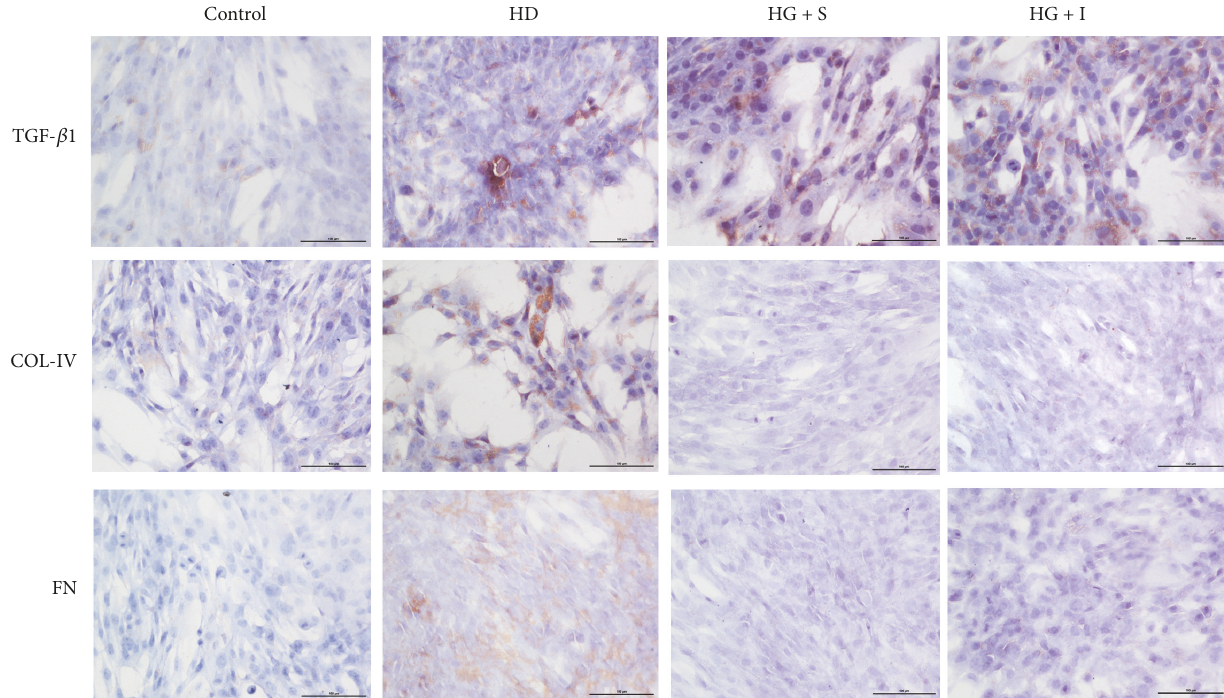
Figure 6: SYFSF serum inhibited fi brotic cytokine expression in high-glucose-treated mesangial cells. SYFSF inhibited the expression of TGF- β 1, collagen IV, and fi bronectin in high-glucose-treated mesangial cells. HG +S represents the mesangial cells treated with high-glucose medium and serum from rats treated with SYFSF. HG+ I represents the mesangial cells treated with high-glucose medium and serum from rats treated with e ff ects of SYFSF on DKD. NF- κ B is a transcription factor